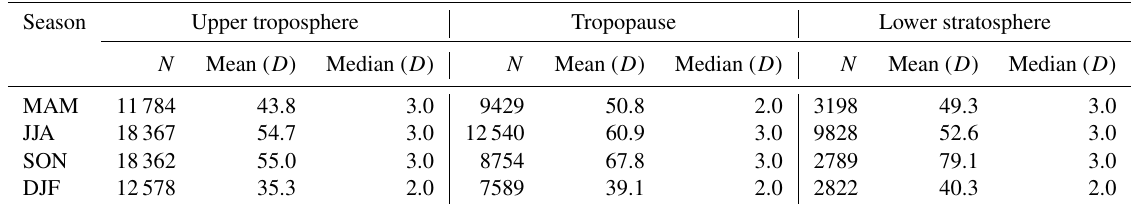
Table 7. Mean and median of the distance D (km) between ISSRs in the IAGOS data set for the upper troposphere, tropopause and lower stratosphere for the MAM, JJA, SON and DJF seasons.